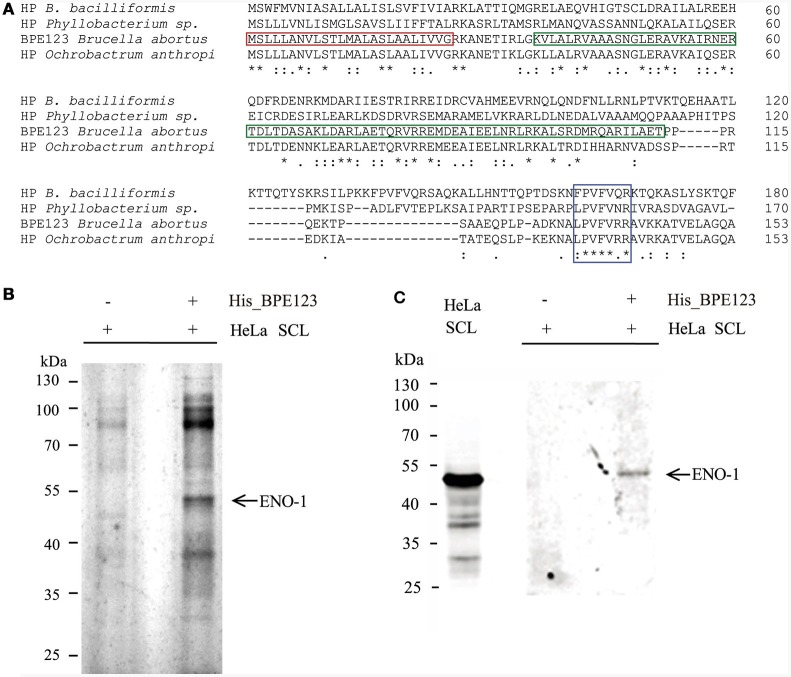
In vitro interaction analysis between His_BPE123 and host-cell proteins by pull-down assay. (A) Clustal Omega alignment of B. abortus BPE123 and homologous hypothetical proteins (HP) from Ochrobactrum anthropi, Bartonella bacilliformis KC583, and Phyllobacterium sp. YR531. The red box indicates the Sec secretion signal (predicted by PSORTb tool), the green box indicates the CC motif (predicted by COILS) and the blue box indicates the most conserved region between the proteins. The asterisks indicate identical residues, double dots indicate strong similarity and the single dots indicate weaker similarity. (B) HeLa soluble cell lysates (SCL) were incubated with cobalt chelate affinity resin preloaded with His_BPE123 or with unloaded resin. After washing, bound proteins were eluted with 290 mM Imidazole. Samples containing eluates were resolved by SDS-PAGE and bands visualized by silver staining. The differential band visible in the His_BPE123 eluate (arrow) was identified by LC/MS-MS as alpha-enolase (ENO-1). (C) Similarly prepared samples were resolved by SDS-PAGE, transferred to nitrocellulose and immunoblotted with an anti-ENO-1 polyclonal antibody.